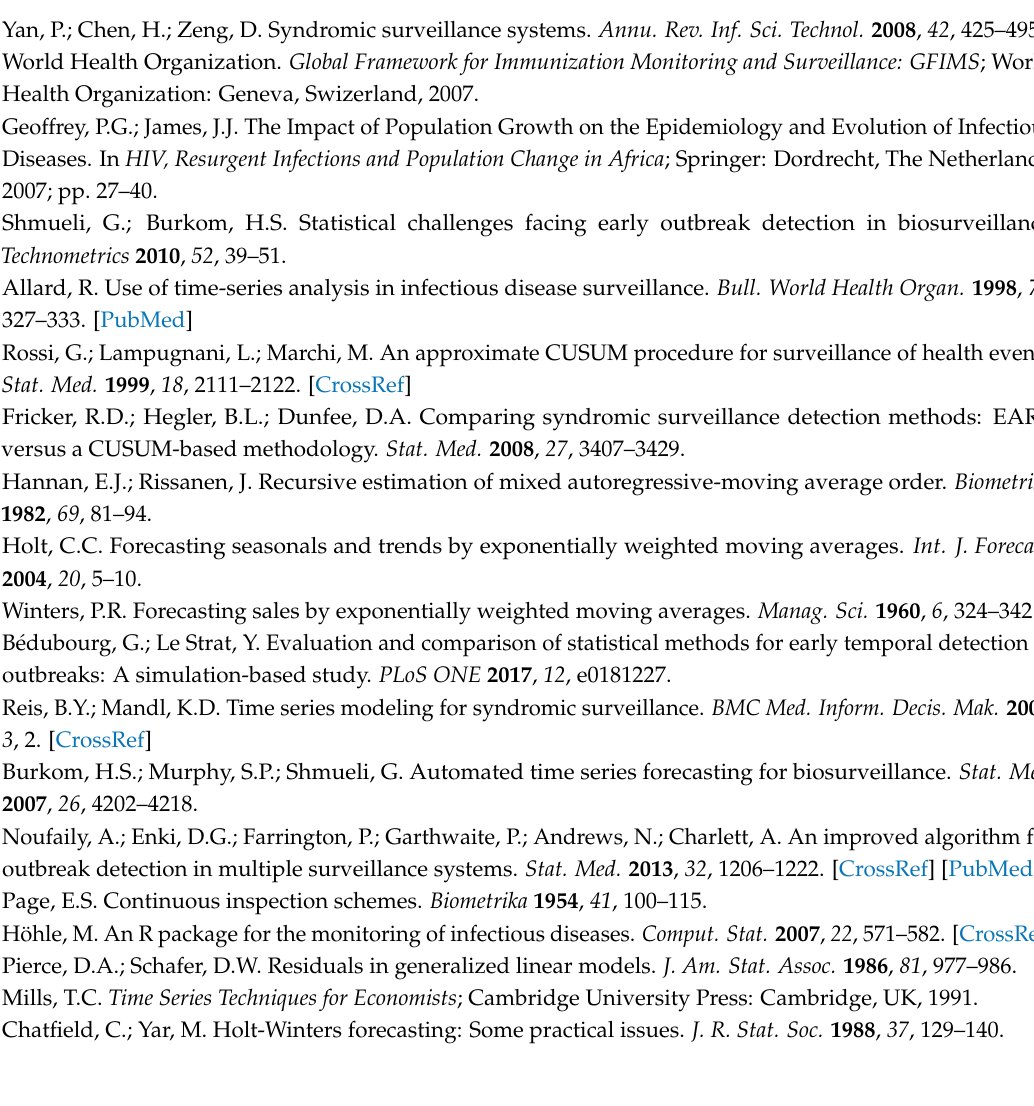
Table S1: 42 scenarios used to generate data, Table S2: The average result of the best CUSUM (glm with trend) algorithm, Table S3: The average result of the EARS C3 algorithm, Table S4: The result of the ARIMA algorithm, Table S5: The result of Holt-Winter algorithm, Figure S1: Daily syndromic diarrhea surveillance data, Figure S2: Weekly syndromic diarrhea surveillance data, Figure S3: The results of the selected algorithms for daily real data, Figure S4: The results of the selected algorithms for weekly real